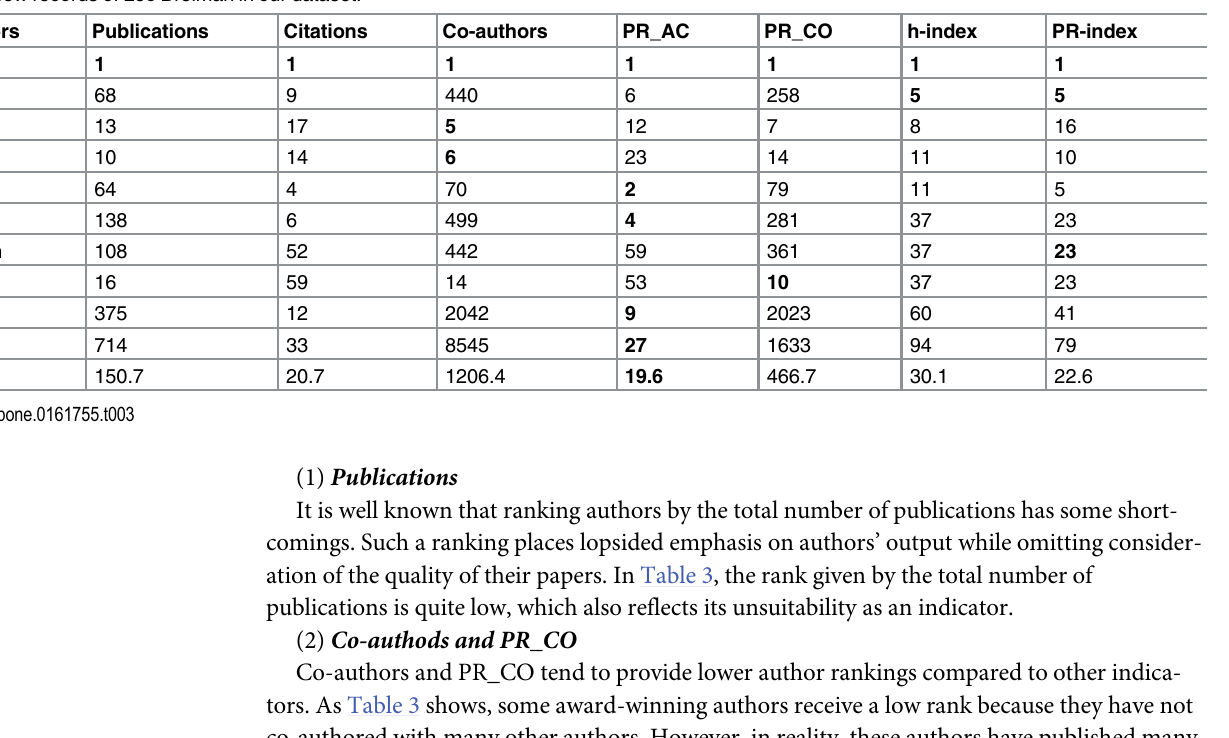
Table 3. Comparison of ranks of authors who are SIGKDD innovation award winners based on different indicators. The boldface refers to the mini- mum number of each row. PR_AC gives the highest ranking to awarded authors. Leo Breiman who awarded the SIGKDD innovation award in 2005 is not list in this table. Actually, our dataset is clawed based on the keyword “ data mining ” and Prof. Leo mainly focuses on the statistics and machine learning. There- fore, there are a few records of Leo Breiman in our